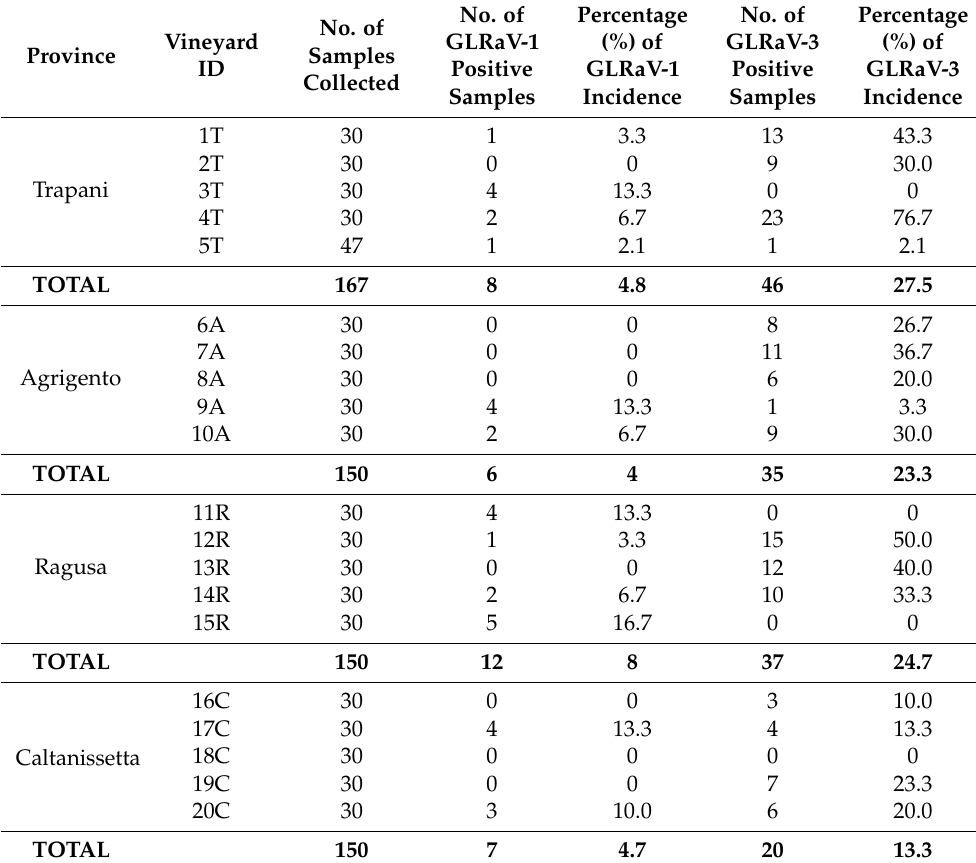
Table 5. Number of samples collected and incidence percentage of Grapevine leafroll-associated virus 1 and Grapevine leafroll-associated virus 3 for each vineyard. No. of No. of GLRaV-1 Vineyard Province Samples Positive ID Collected